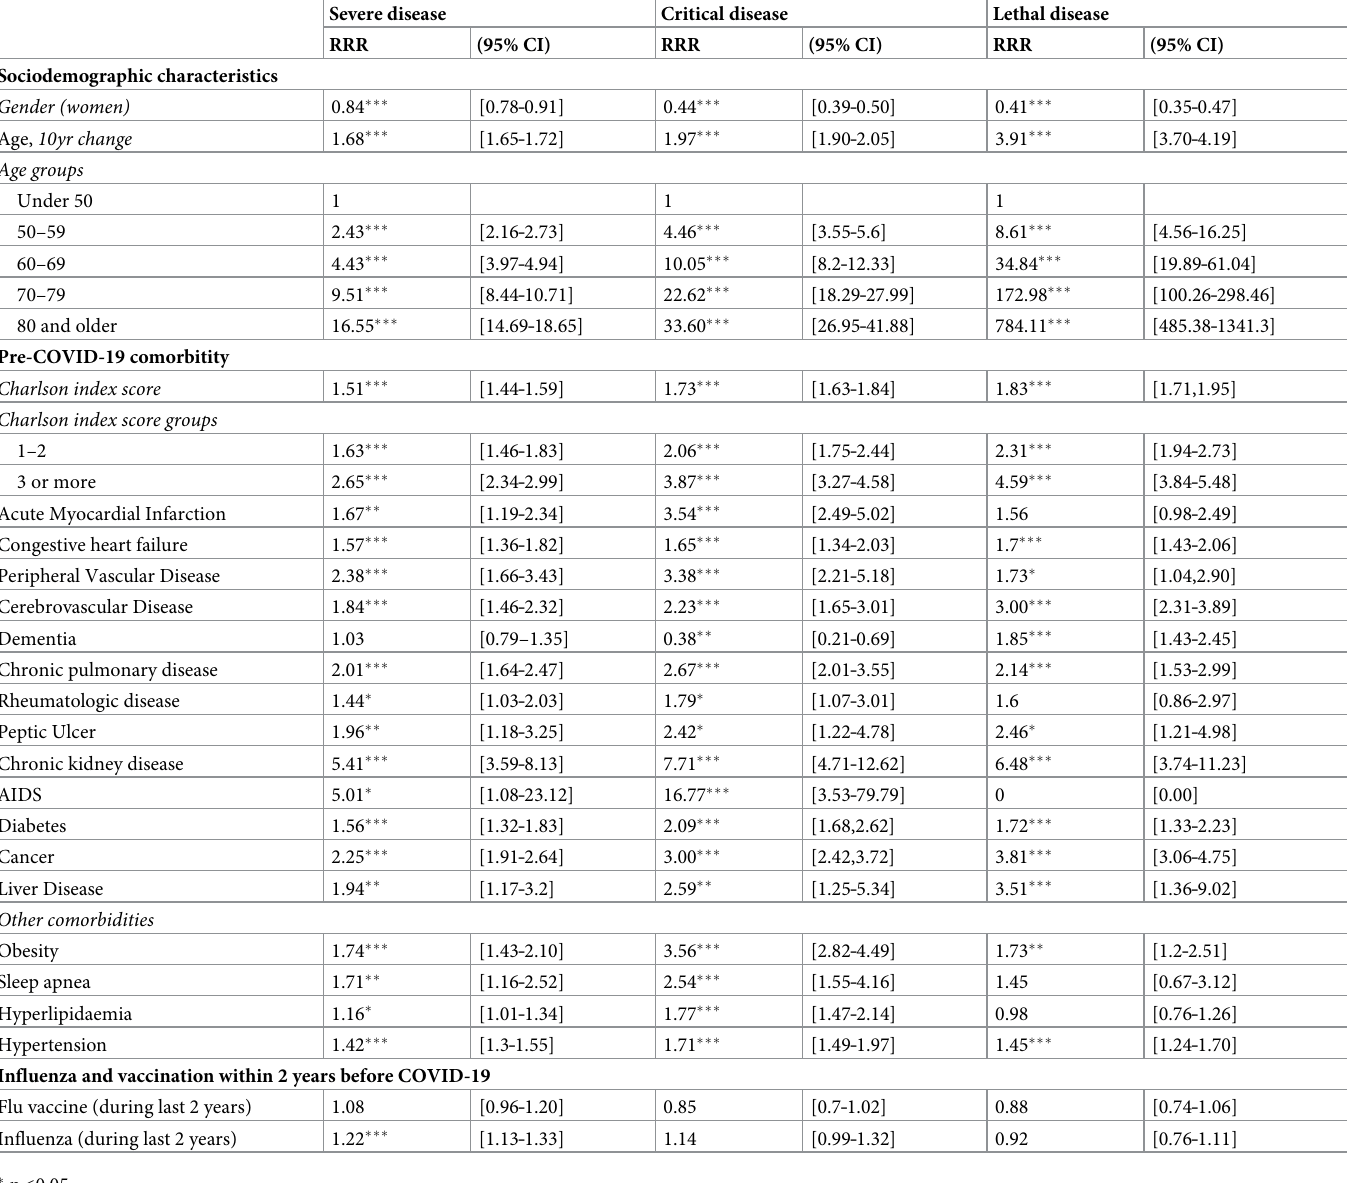
Table 2. Multivariable analysis of patient characteristics associated with acute COVID-19 severity in Estonia for the period of 26 February 2020 to 28 February